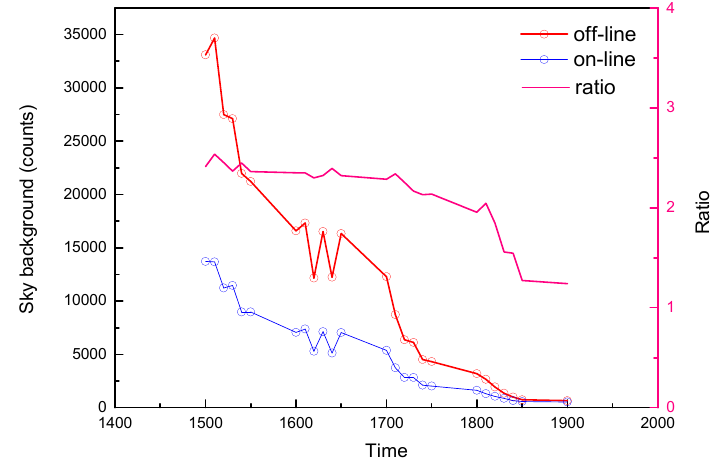
Figure 6. Variation of the on-line and off-line wavelength from the sky background from 07:00 to 11:00 UTC (15:00–19:00